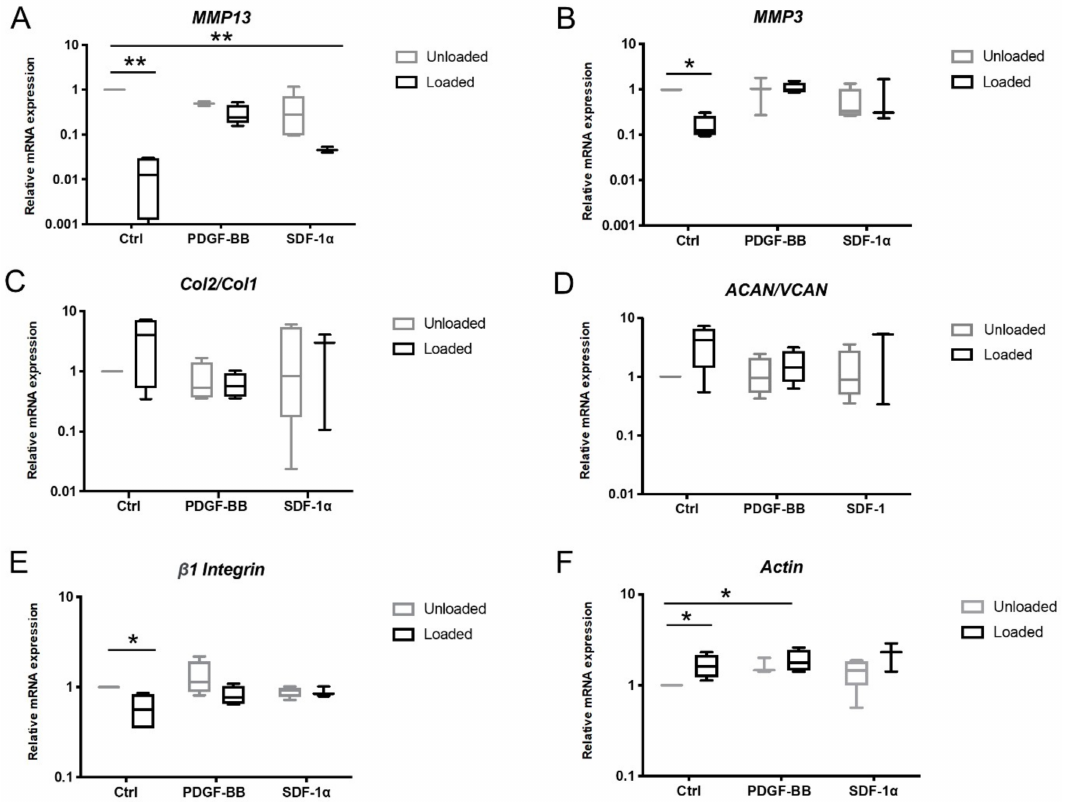
Figure 3. E ff ect of articular load and motion on phenotype of cells recruited into the wound site. ( A – F ) mRNA expression of cells infiltrating FB / HA hydrogels implanted into the osteochondral defect explant and exposed to complex load for 15 days. Data are expressed relative to mRNA levels of unloaded samples presented in the graphs by the first line. Results from four di ff erent donors (one osteochondral explant per donor) are shown; * p < 0.05, ** p <